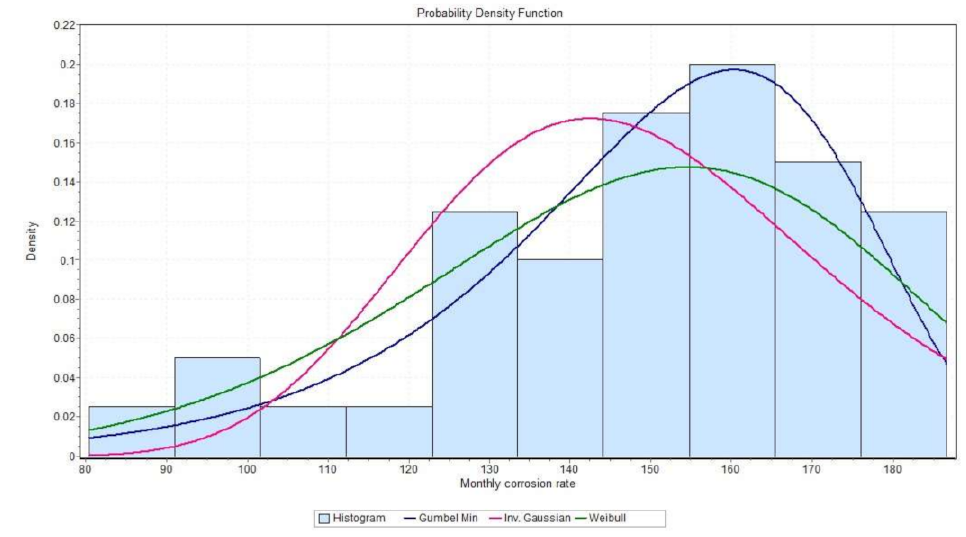
Figure 10. PDF graphics for the three best fitted two-parameter distributions for sea influence PDF and CDF for GumbelMin, Weibull, and Inverse Gaussian distribution, denoted ( x ) , F we ( x ) , and f ig ( x ) , F ig ( x ) are by f gm s ( x ) , F gm s ( x ) , f we s s s s